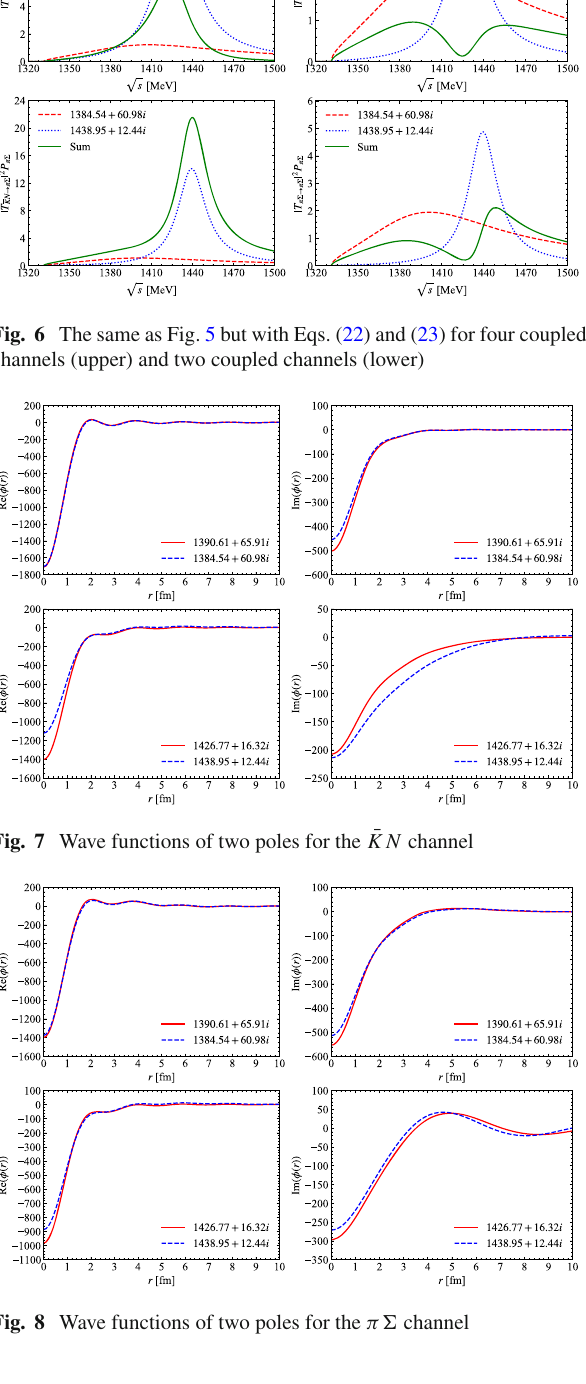
still the same as the one in the coupled channel case. With the form factors obtained from the wave functions, the radii evaluated with Eq. (17) for two poles are given in Table 8. Analogously, the radius for the higher-mass pole of